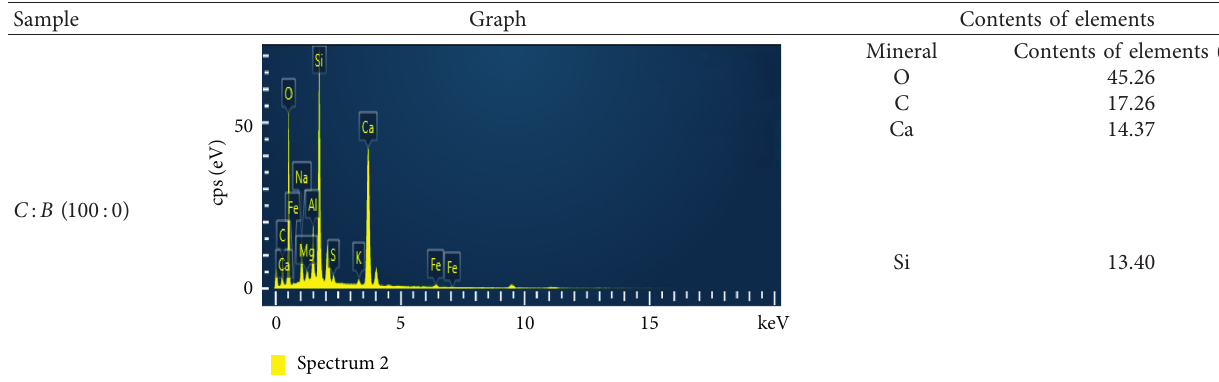
Figure 8: SEM photos of reinforcing fibers: (a) specimen reinforced with a large amount of aramid fibers (250x); (b) specimen reinforced with a large amount of aramid fibers (500x); (c) sample reinforced with a large amount of carbon fibers (250x); (d) sample reinforced with a large amount of carbon fibers (500x). Table 5: Findings from EDX analysis for C : B of 100: 0%.